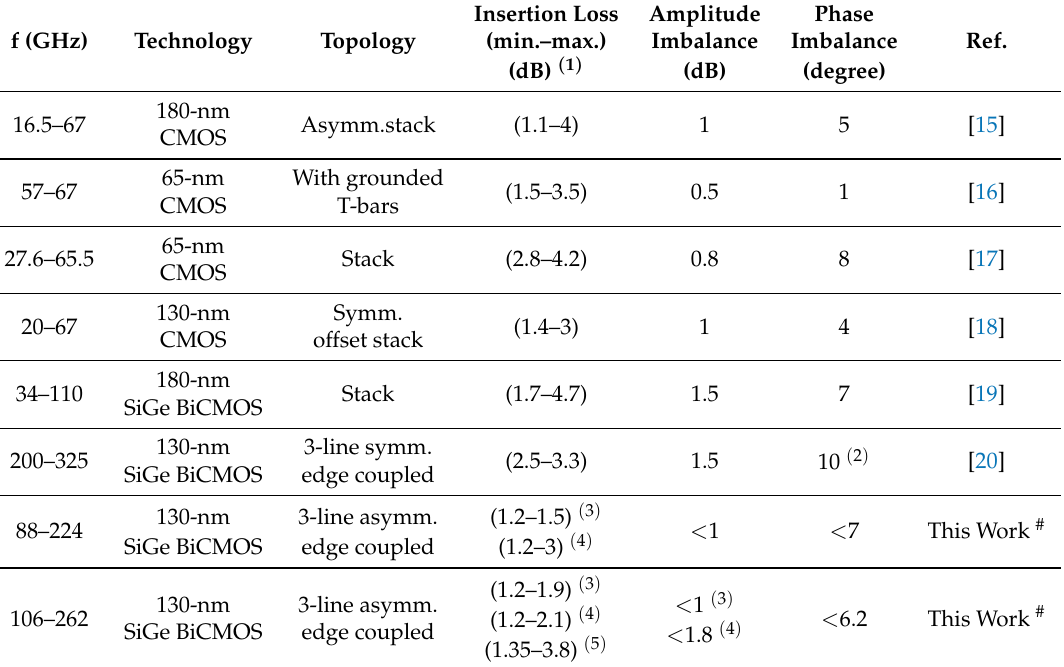
Table 1. State-of-the-art balun